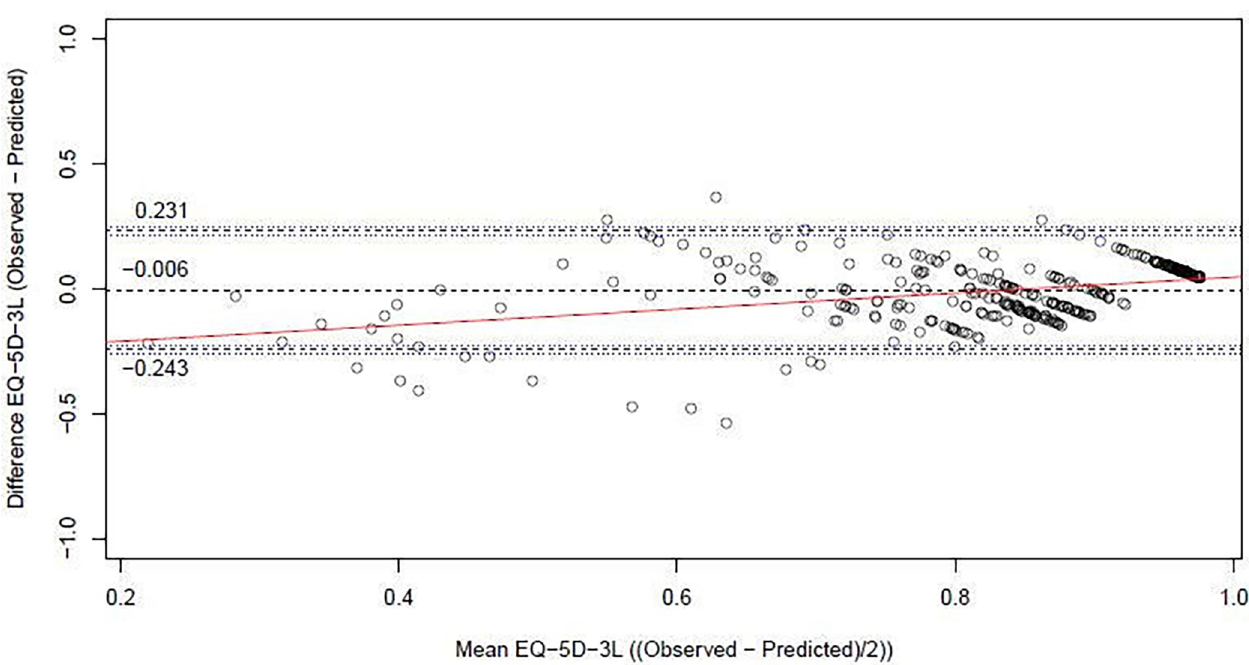
Fig 2. Bland-Altman plot of the final model with observed and predicted EQ-5D-3L values.